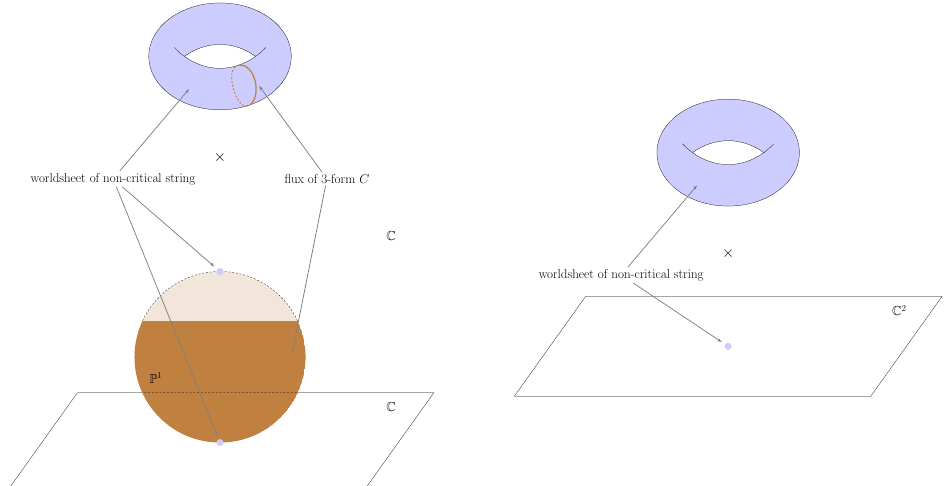
Figure 3 . Localised contributions to the partition function of 6d SCFT on T 2 × b C 2 (left) and on T 2 × C 2